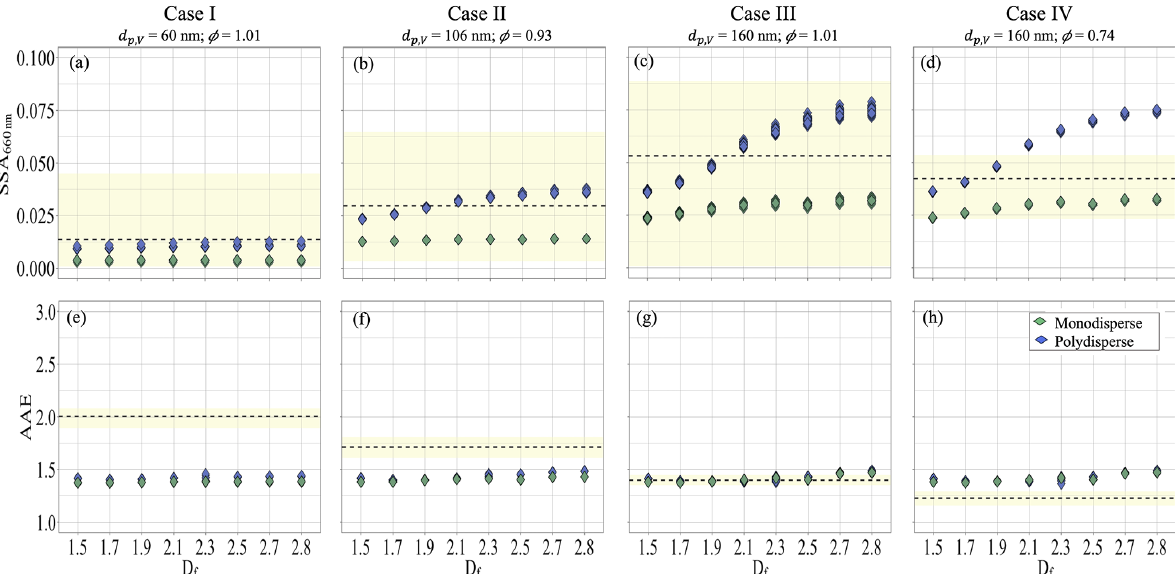
Figure 8. Sensitivity analysis of the modelled SSA and AAE using the “aggregate” representation. The fractal dimension D f was varied between 1.5 to 2.8 for cases I–IV of E1, modelling the SSA (a–d) and AAE (e–f) . The experimentally measured values are highlighted by the yellow area in the figure, and the dashed line represents the mean measured SSA or AAE for each case.